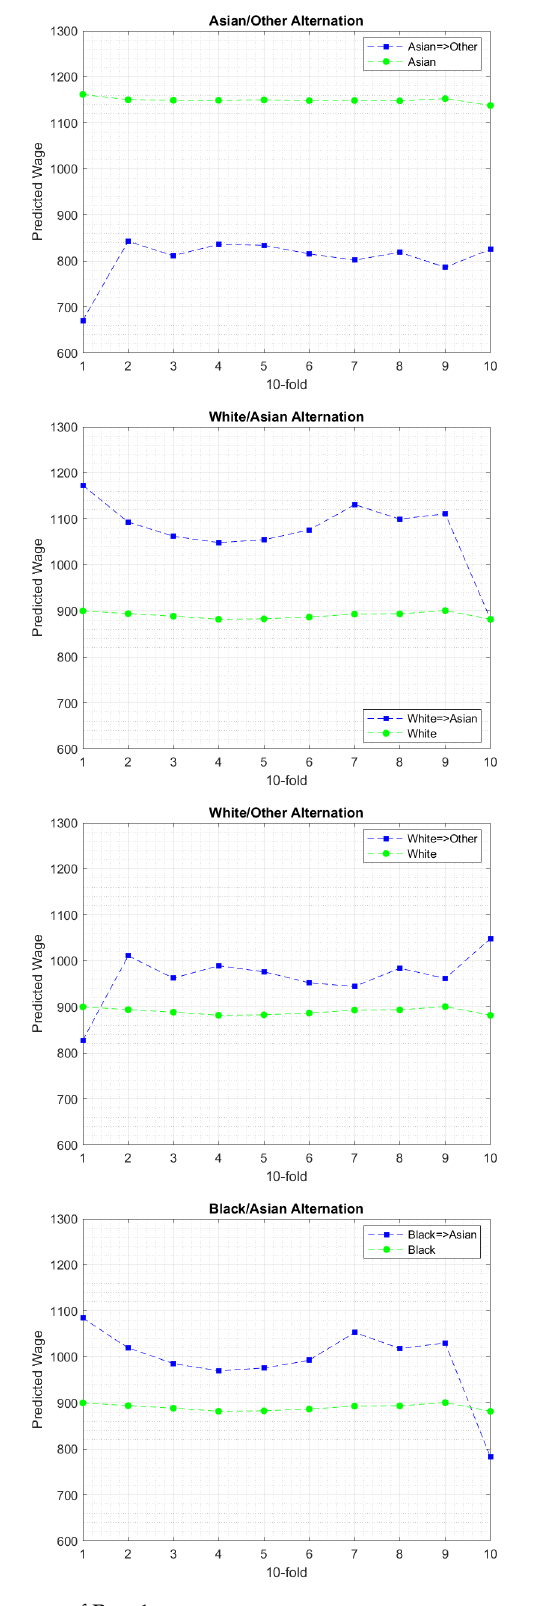
Figure 5. Bias in wages in terms of